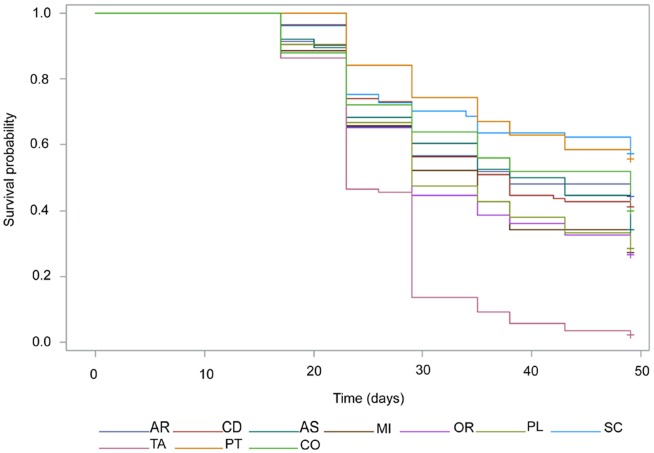
Survival function for the event of wilting by populations of P. pinaster plants inoculated with F. circinatum at time 0 and estimated by the Kaplan-Meier method (2013 trial).